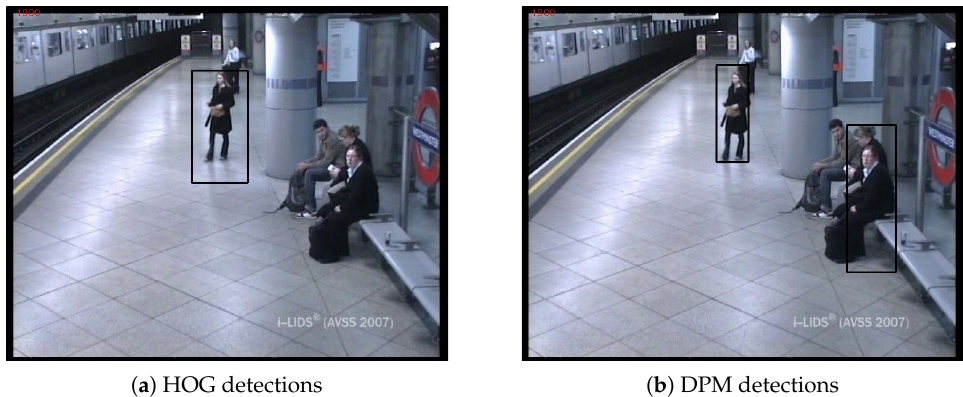
Figure 5. People detection results using HOG [95] ( a ) and Deformable Part Model (DPM) [96] ( b ) algorithms in AVSS AB 2007 http://www.eecs.qmul.ac.uk/~andrea/avss2007_d.html. As we